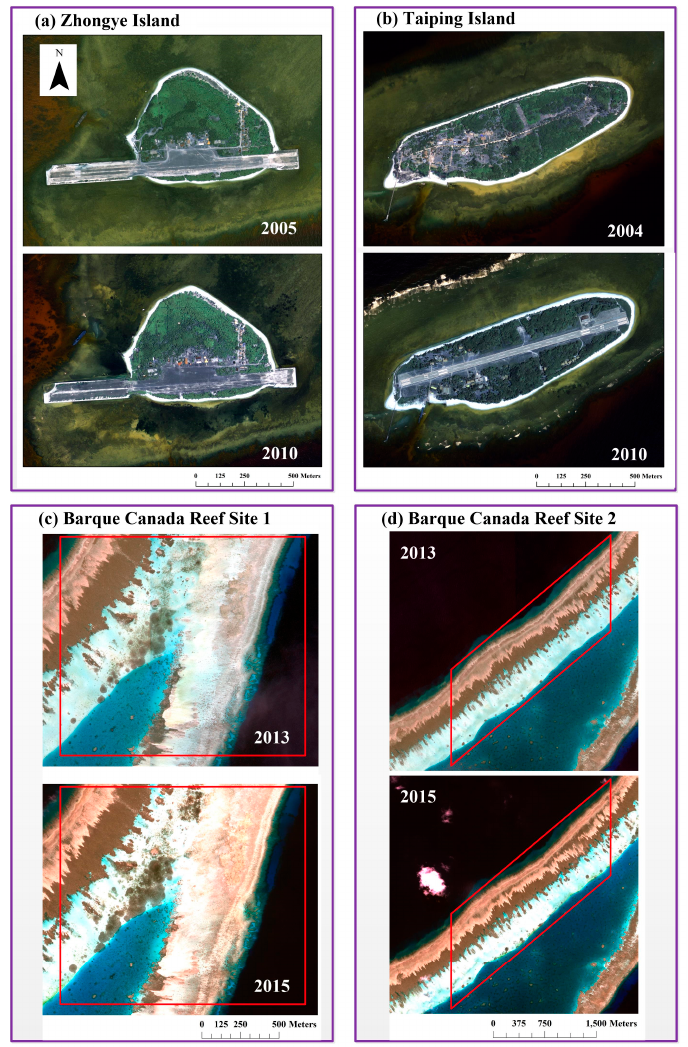
Figure 1. Four coral reef study sites: ( a , b ) QuickBird satellite images of Taiping Island and Zhongye Island (Bands 3, 2, and 1 in RGB); ( c , d ) WorldView-2 satellite images of Barque Canada Reef (Bands 5, 3, and 2 in RGB), where red rectangles indicate the two study sites in Barque Canada reef. Zhongye Island (11°03 ′ 6 ″ N, 114°17 ′ 12 ″ E) is of triangular shape, covering an area of roughly 0.372 km 2 . Zhongye Island has a long history of habitation by fishermen. The island is covered by